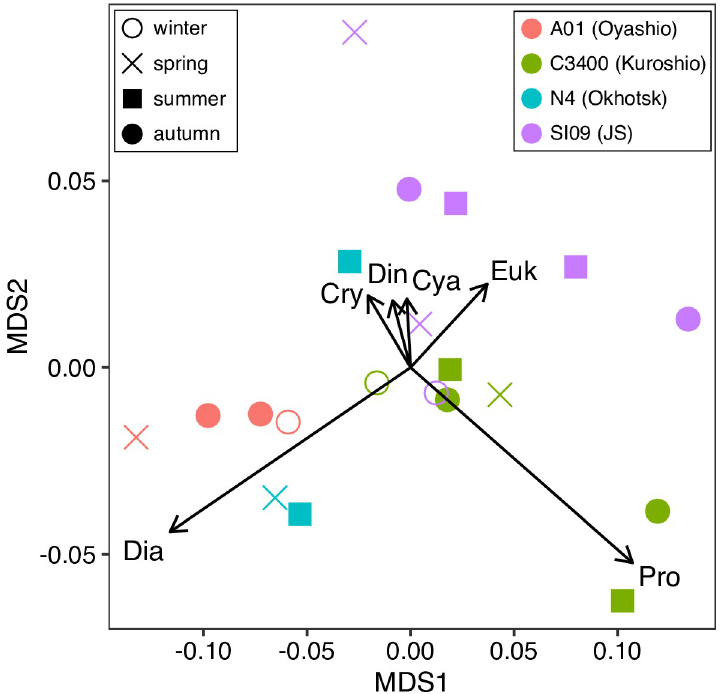
Fig 10. Similarities of proportion to TChla-based biomass in the water column among the observations. Similarities were calculated on the Bray-Curtis index and the non-metric multidimensional scaling (nMDS). The shapes and colors of the symbols indicated the sampling season and stations, respectively. The arrows with text denote the effect of phytoplankton chemotaxonomy groups (Cry: Cryptophytes, Euk: Eukaryotes, Pro: Prochlorophytes, Cya: Cyanophytes, Dia: Diatoms, and Din: